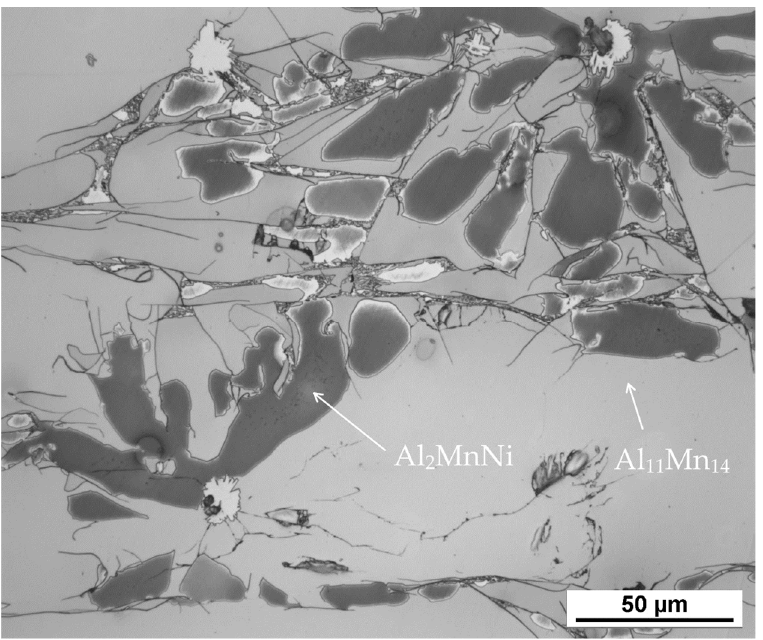
Figure 2. The microstructure of alloy with 100 % excess of aluminum over stoichiometry in the reduced state. Table 3. Chemical composition of the individual phases in the sample in the reduced